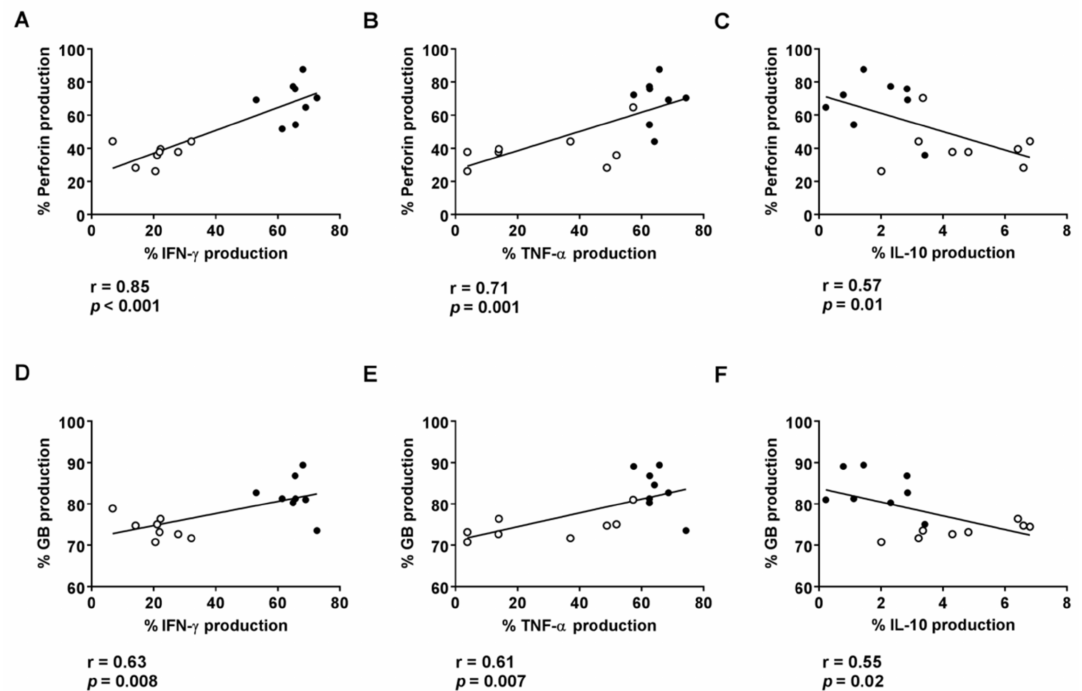
Figure 4. Correlation between the percentages of CD8+ HLA-DR+ T cells with induced intracellular IFN- γ ( A , D ), TNF- α ( B , E ) or IL-10 ( C , F ) and cytotoxic granules after 72 h culture of HD PBMCs with plasma from R and NR patients. Spots in black correspond to R plasma and spots in white to NR